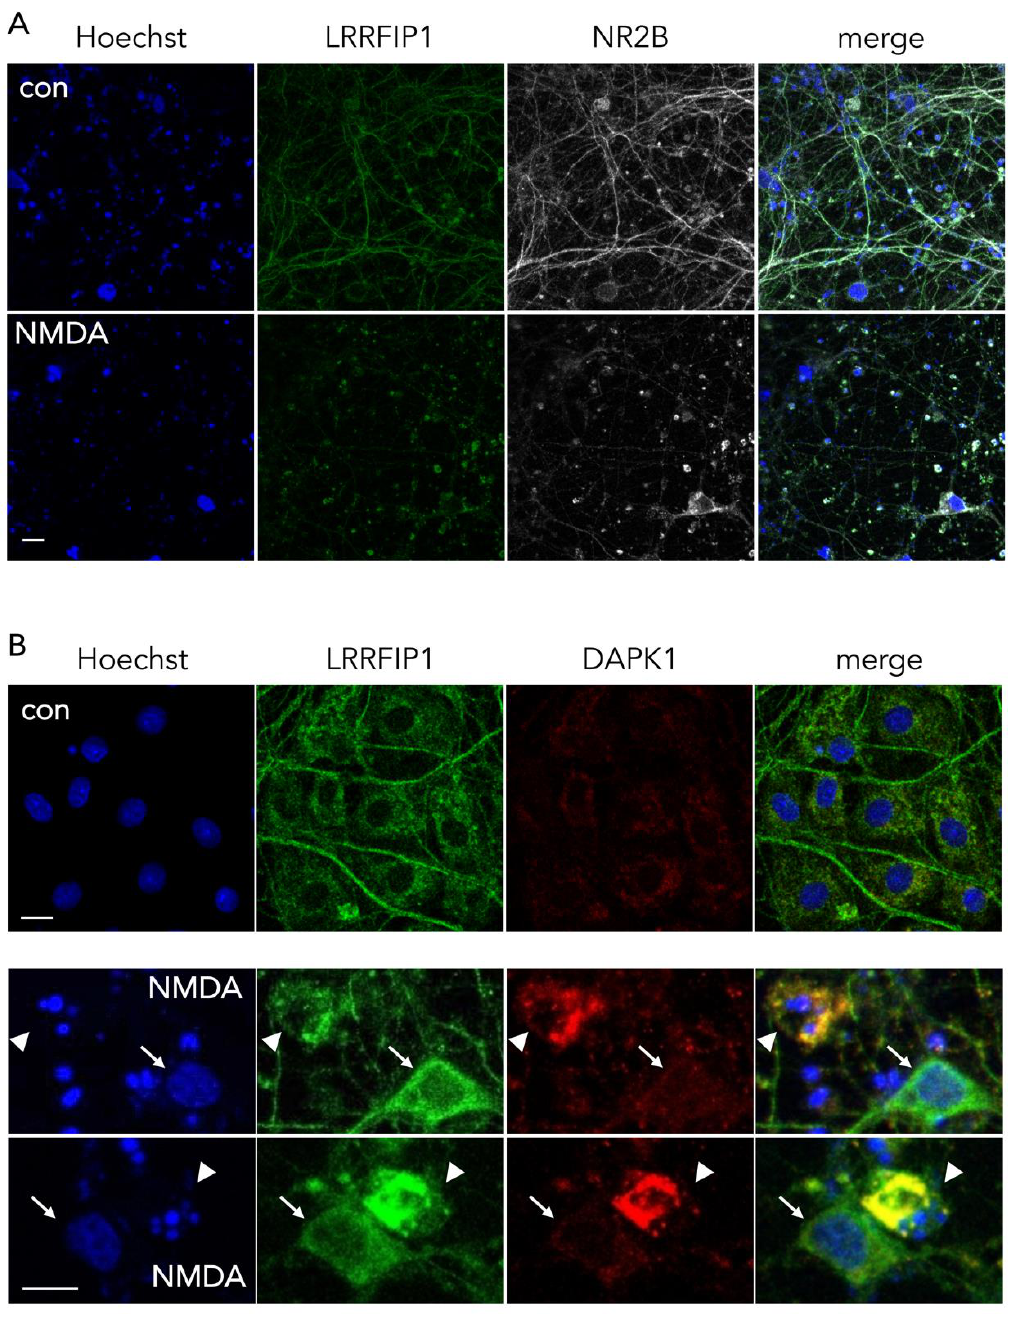
Figure 7. Representative ICC images showing the colocalization pattern of NR2B and DAPK1 with LRRFIP1. ( A ) Images showing the main cellular location of LRRFIP1 and NR2B in control and NMDA-treated neurons in vitro; scale bar: 30 µm. ( B ) Images showing the colocalization pattern of LRRFIP1 and DAPK1 in control neurons (upper panel, con), and in neurons with normal (arrows) or pyknotic (arrowheads) nucleus shortly after NMDA treatment (lower panels, NMDA); scale bars: 10 µm.